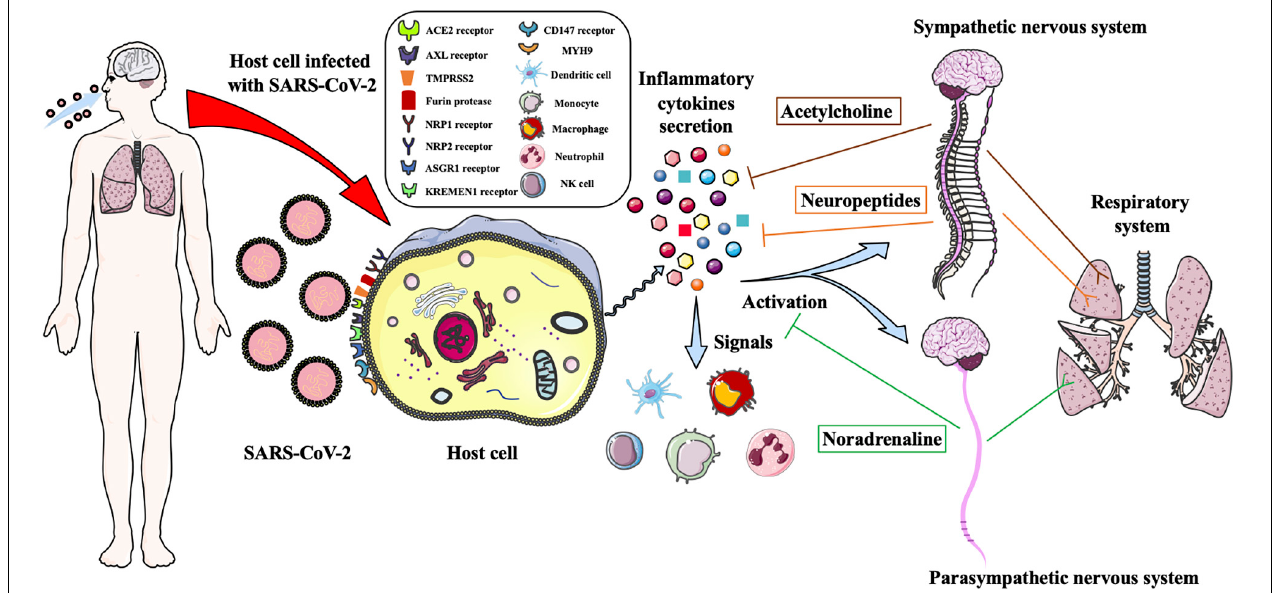
FIGURE 1 | Schematic illustration of the autonomic nervous system regulates the innate immune response to defense against SARS-CoV-2 infection. SARS-CoV-2 infects target cell of human respiratory system through binding the ACE2, AXL, NPR1, NPR2, ASGR1, KREMEN1 and CD147 receptors, and could be facilitated cell entry via TMPRESS2, furin protease and MYH9. The infected cells are triggered to secrete massive proinflammatory cytokines, which could signal the immune cells to move to the viral infected sites and activate the sympathetic and parasympathetic nervous system to regulate the immune response. The noradrenaline and acetylcholine neurotransmitters and neuropeptides are produced to balance the cytokines secretion and bind to the adrenergic and cholinergic receptors to control the airways and lungs inflammation and regulate the functions of the respiratory system.